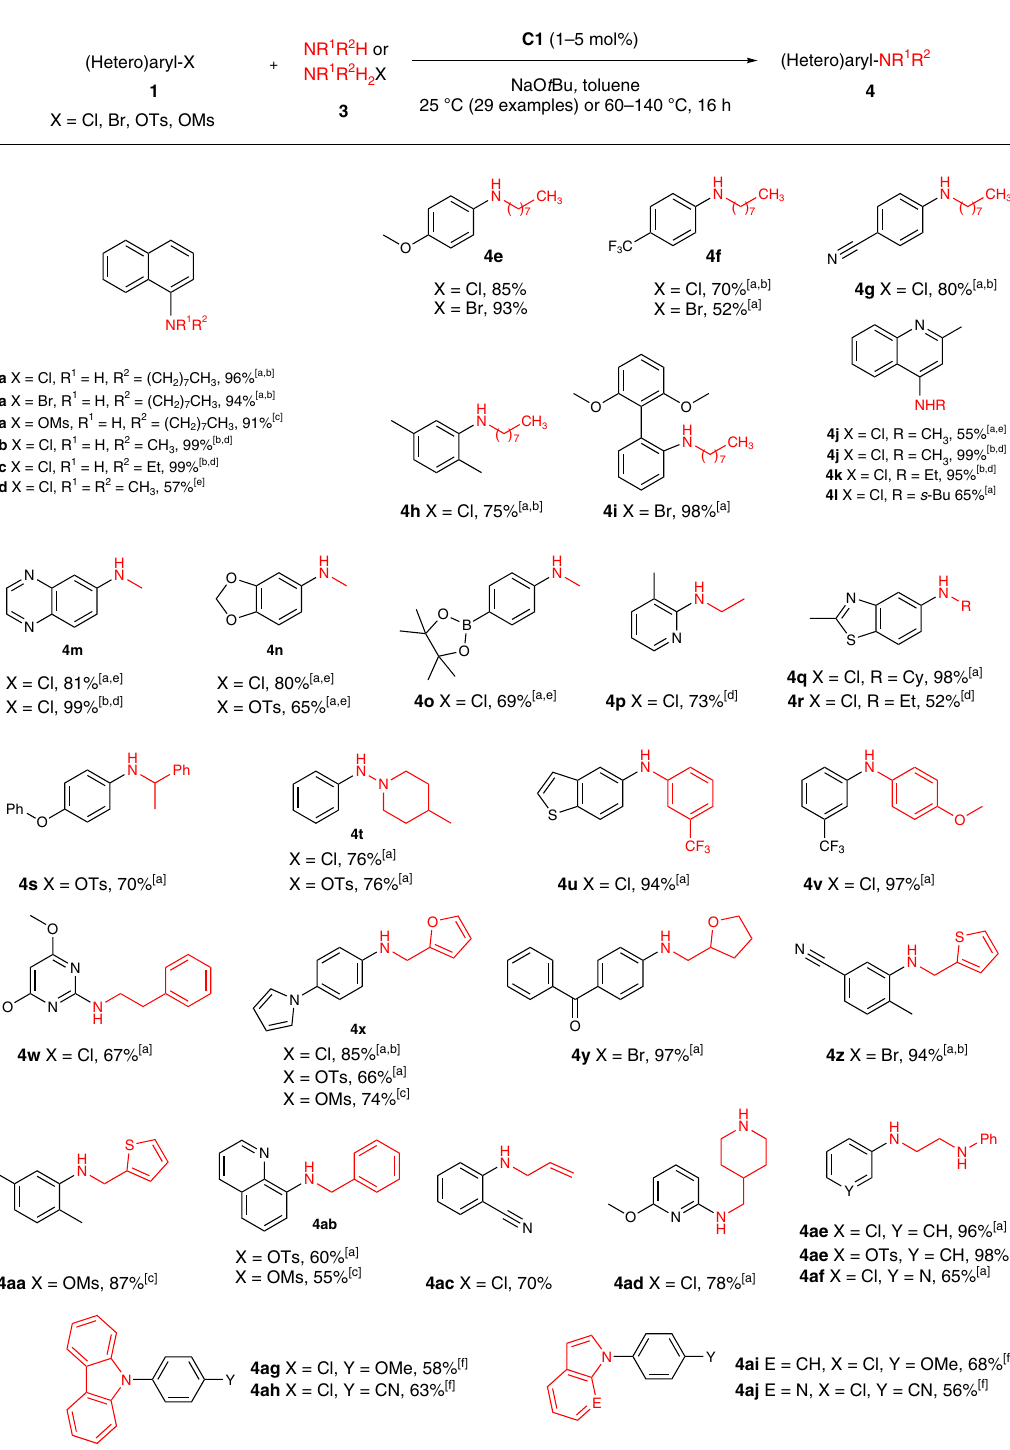
NATURE COMMUNICATIONS|7:11073|DOI: